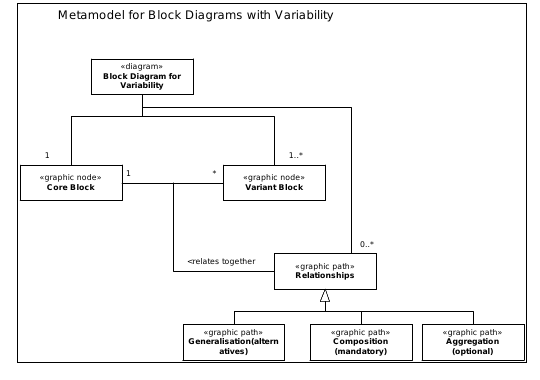
Figure 4. Metamodel for block variability